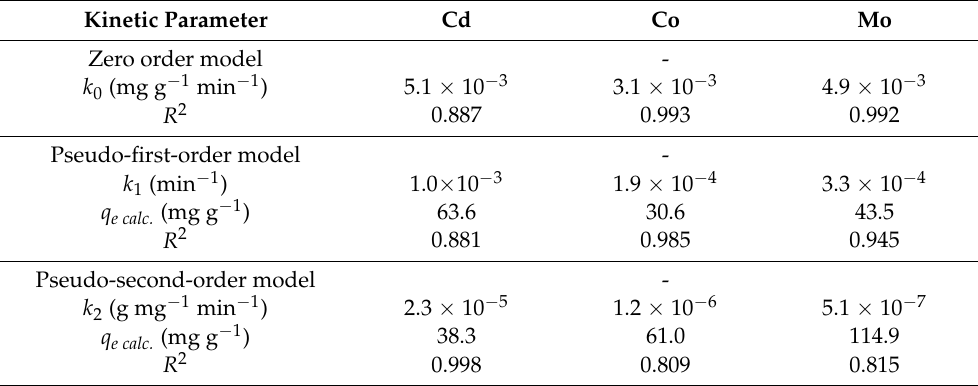
Table 1. Kinetic parameters for the removal of Cd 2+ , Co 2+ and MoO 42 − from aqueous solution by crushed concrete fines.